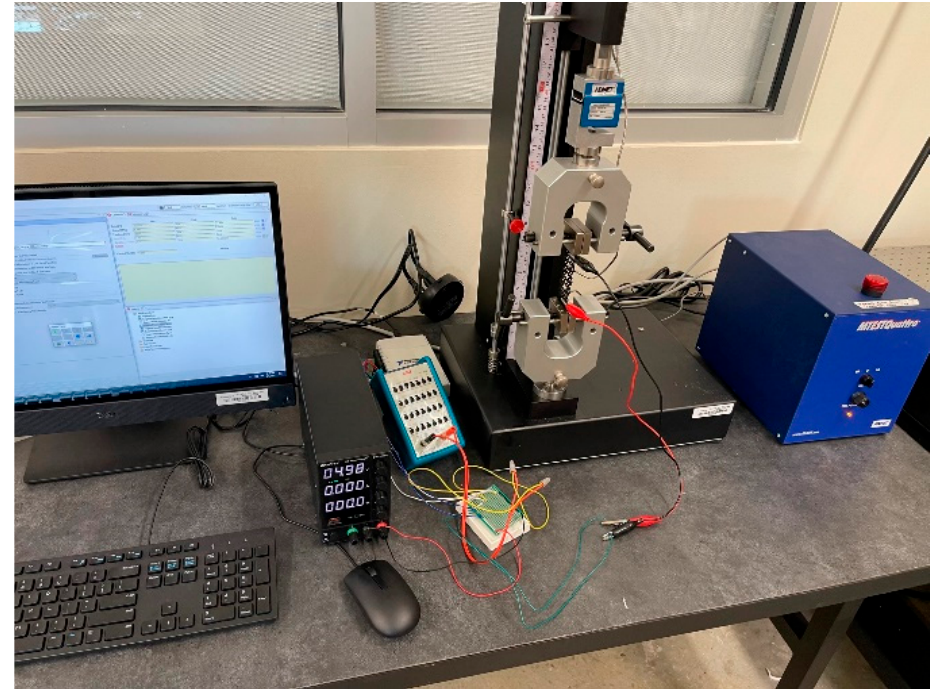
Figure 3. Tensile test machine used in the experiments. Table 1. Initial measured resistance of structure.